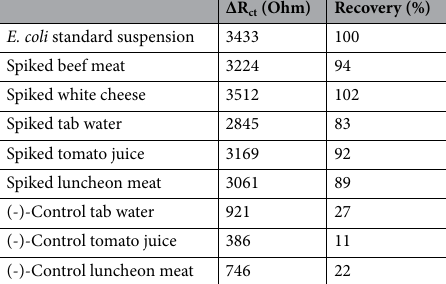
Table 2. Food sample analysis and recovery percentage of bacterial